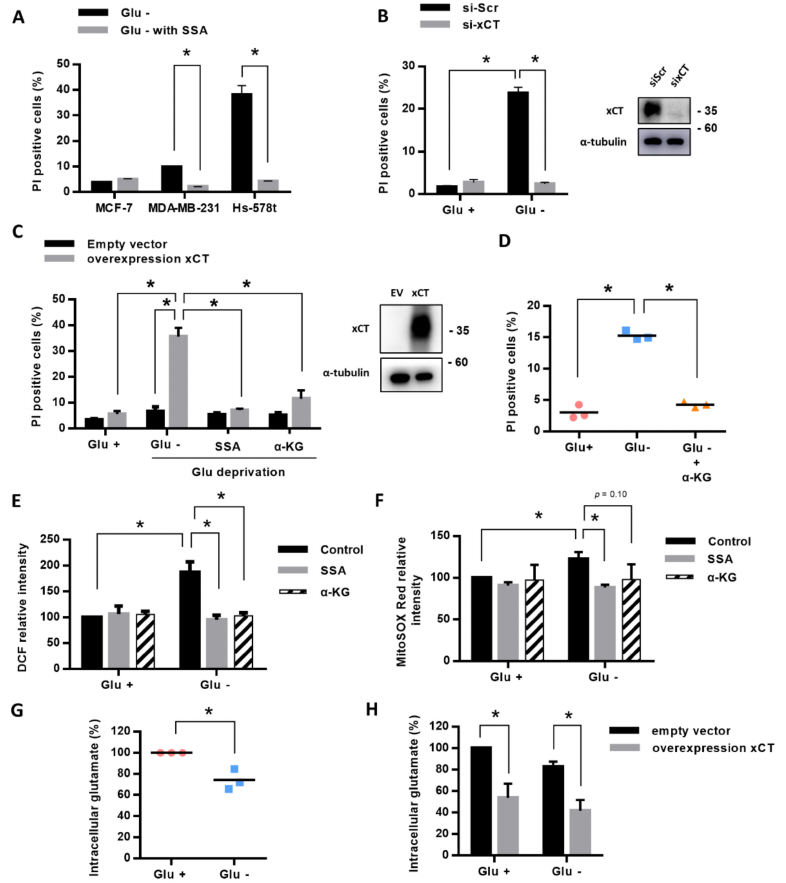
Figure 2. Inhibition of xCT or supplementation with α -KG reduced the ROS levels and rescued cell death in the cells under glucose deprivation. ( A ) Breast cancer cell lines were cultured in the